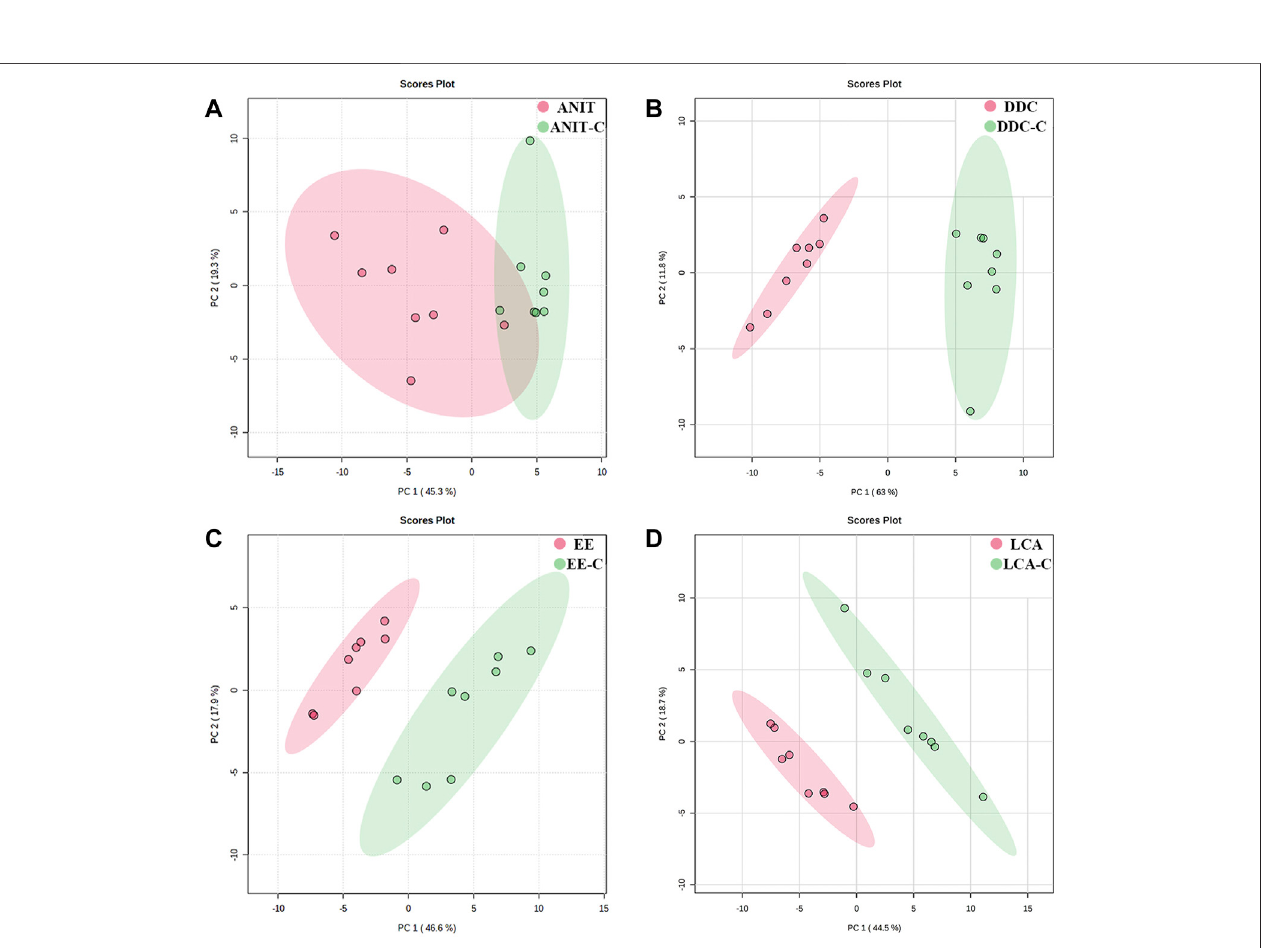
Frontiers in Pharmacology |